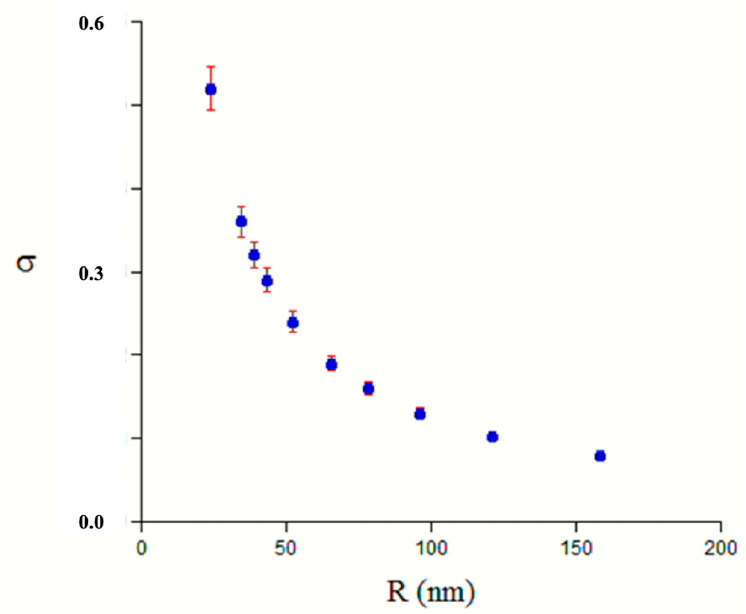
Figure 6. Relation between surface charge density, σ , in Q cm − 2 , and average vesicle radius, R (nm), for cat-anionic vesicles made of unequal amounts of SDS and CTAB. The solution contains 6.2 × 10 − 3 mol kg − 1 , at 25.0 °C, with ionic species in non-stoichiometric ratios. What is reported here refers to a CTAB-rich vesicle. As expected, the surface charge density decreases with the SDS mole ratio in the mixture. The reported behavior is tentatively described by a relation keeping the form σ R = K . A specular behavior is met when the species in excess is SDS and CTAB is added. In that case, obviously, σ is negative.